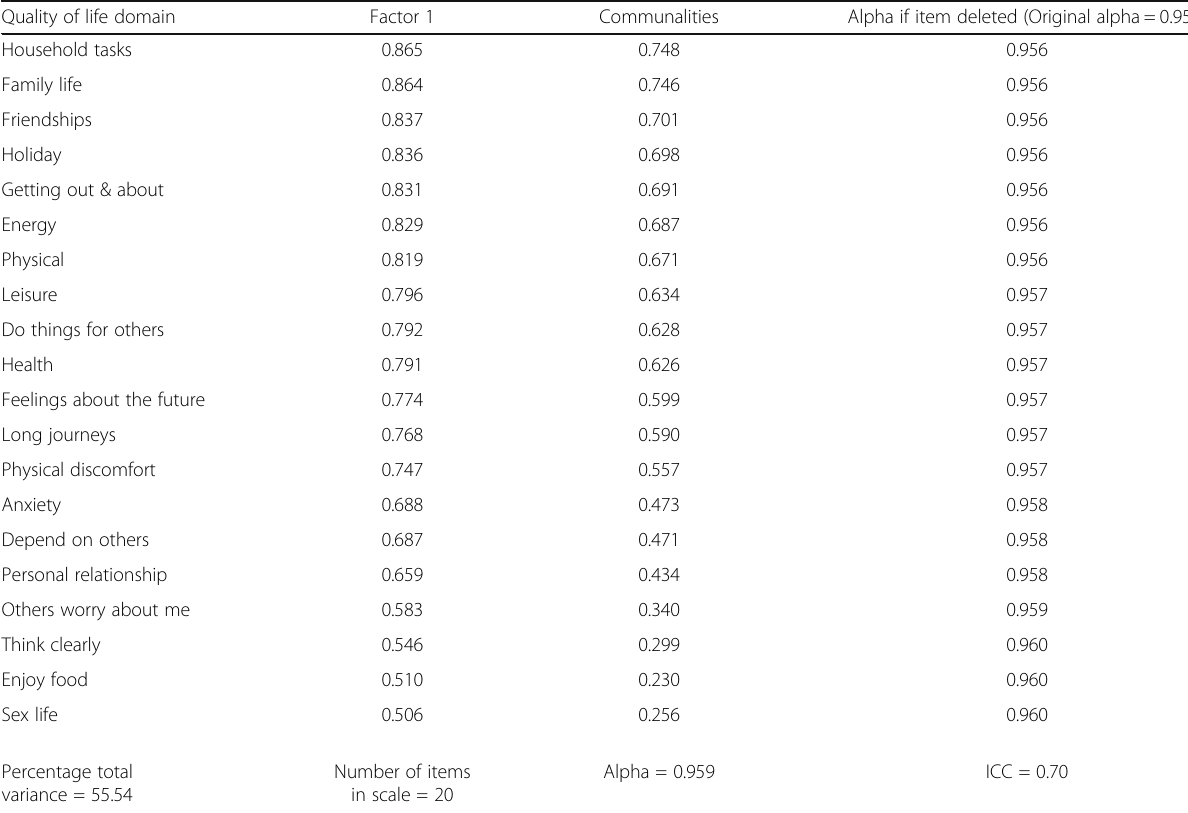
Table 3 AneurysmDQoL - Factor loadings, communalities and reliability coefficients (pre and post-repair patients), ordered by factor loadings Quality of life domain Factor